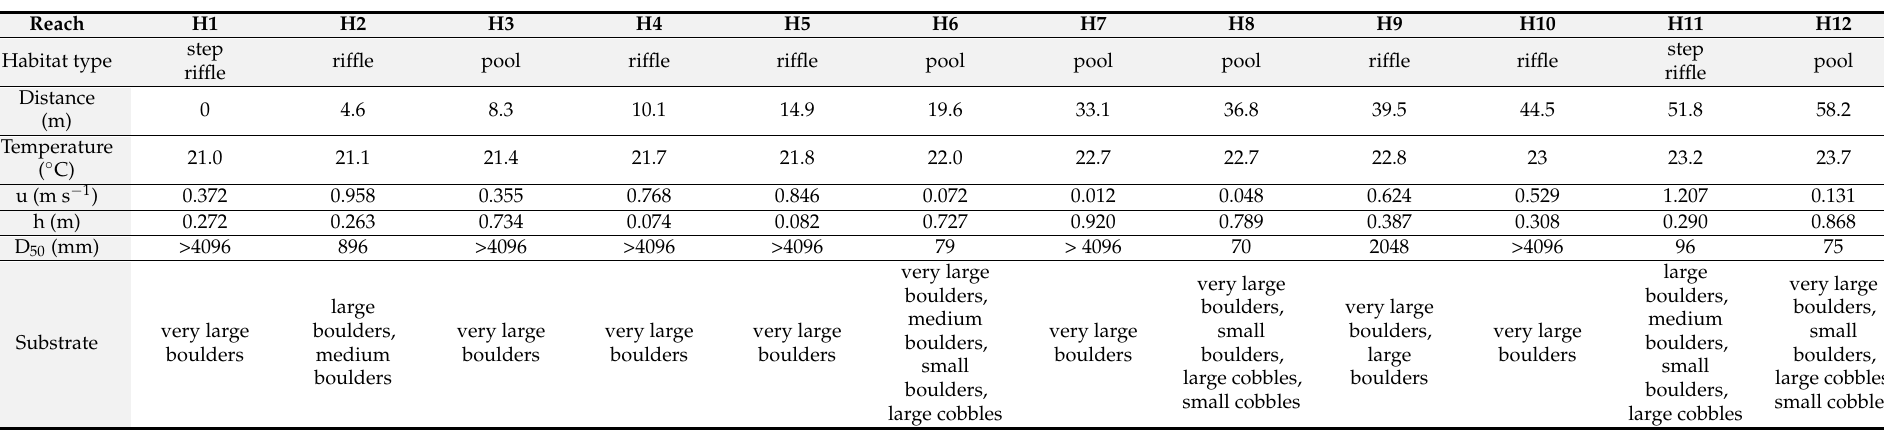
Table 1. Physical factors, distance from a reference point (H1), temperature, flow velocity (u), water depth (h), and the median of the bed substrate sizes (D 50 ), of each surveyed, reach in the